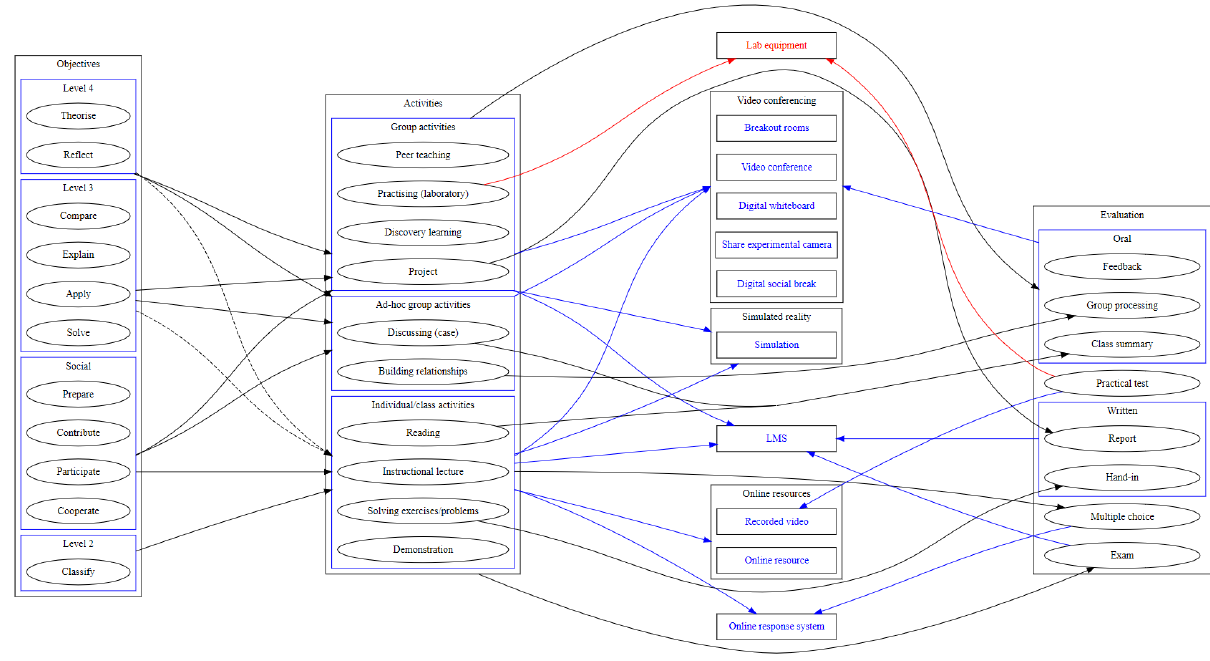
Figure 5: Graph of online learning objectives, learning activities, evaluation methods, and digital and physical resources for a course on mobile